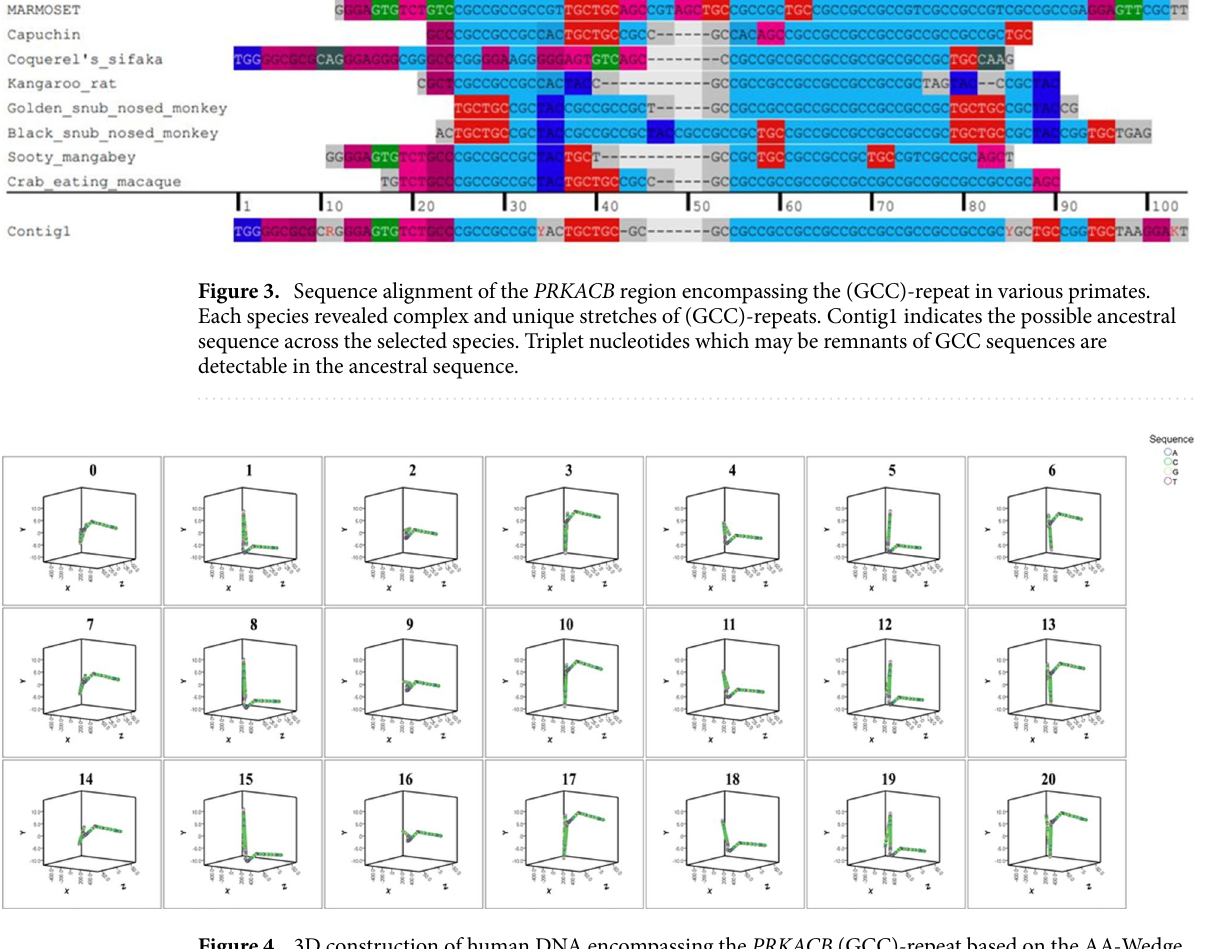
Figure 4. 3D construction of human DNA encompassing the PRKACB (GCC)-repeat based on the AA-Wedge model. Striking similarity was detected in repeats where subtraction or addition of 7-repeats was